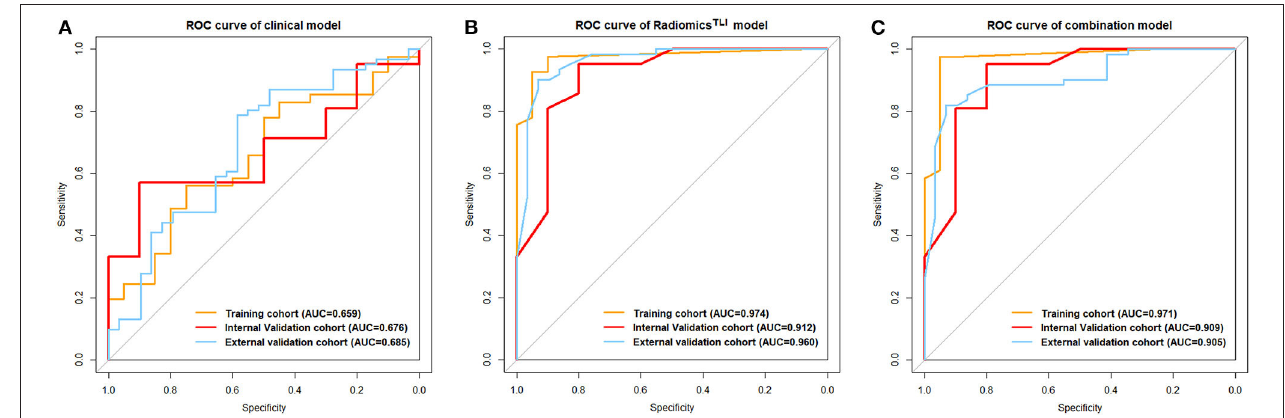
FIGURE 2 | (A) ROC curve for the clinical model. (B) ROC curves for the radiomics TLI model. (C) ROC curves for the combination model.